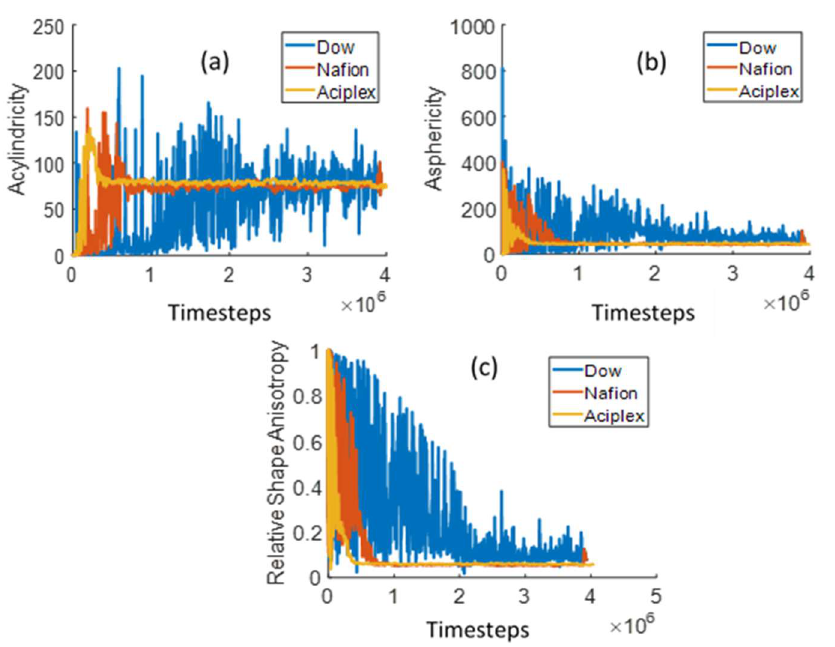
Figure 10. Time evolution of the largest water cluster ( a ) acylindricity, ( b ) asphericity, and ( c ) relative shape anisotropy (RSA) in the 0–26 DPD units range in the Z-direction.